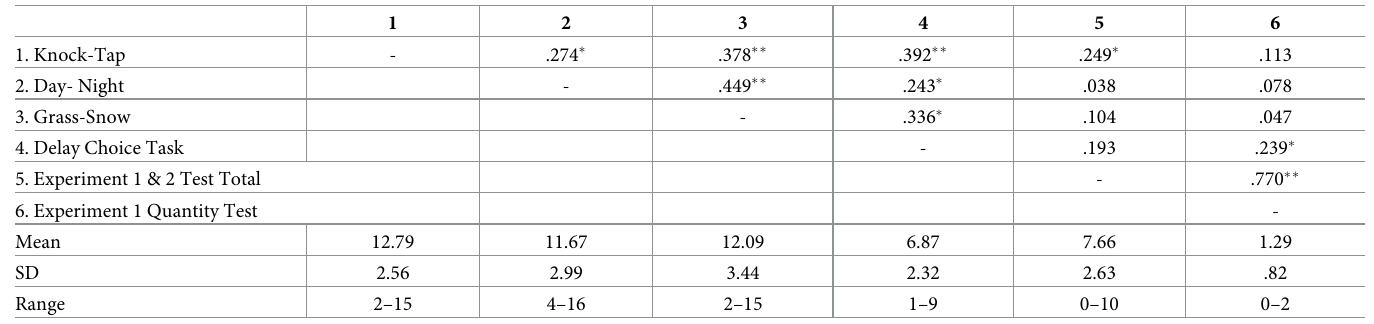
Table 4. Correlations and descriptive statistics for inhibition control and delay choice